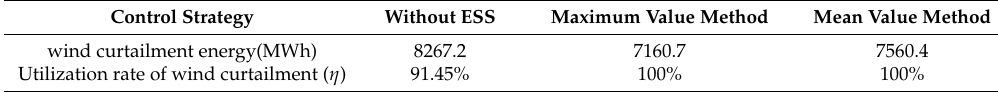
Table 2. Curtailed wind energy and utilization of different control methods.